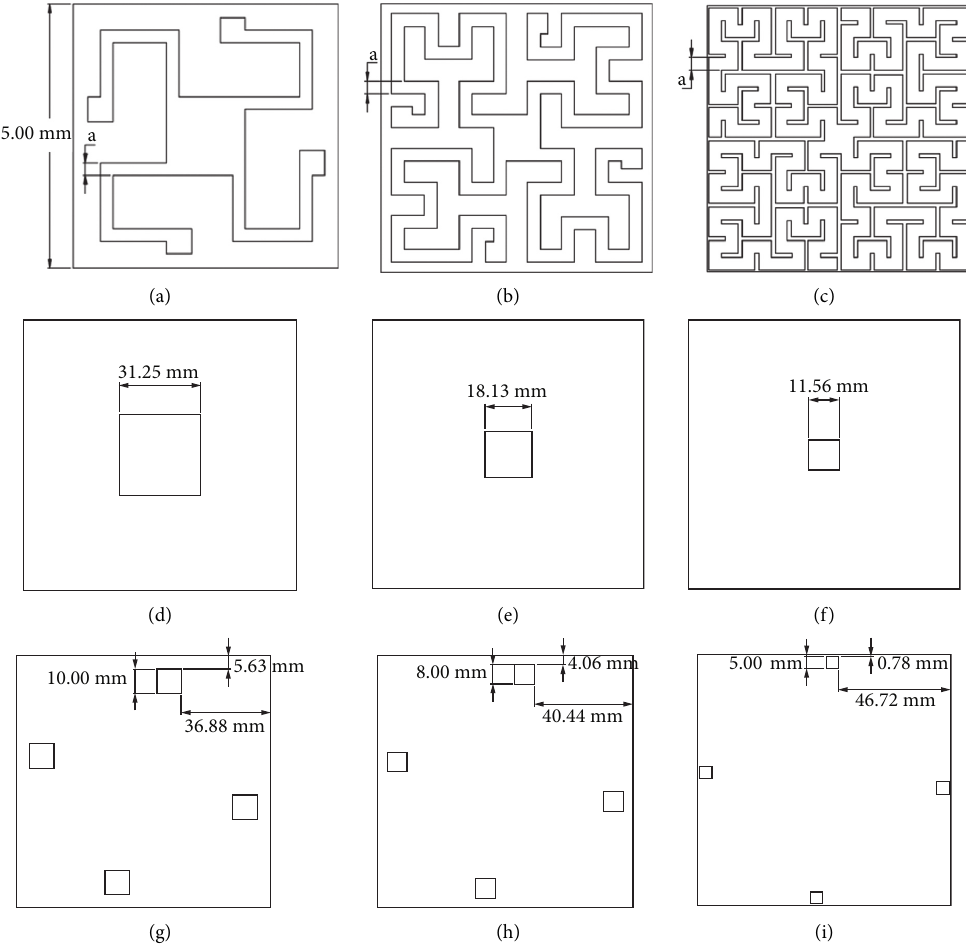
Figure 2: Structural form of coiled acoustic metamaterials of each order based on the Hilbert fractal. (a) First-order Hilbert fractal. (b) Second-order Hilbert fractal. (c) Third-order Hilbert fractal. (d) First-order central perforated plate. (e) Second-order central perforated plate. (f) Third-order central perforated plate. (g) First-order perforated plate. (h) Second-order perforated plate. (i) Third-order perforated